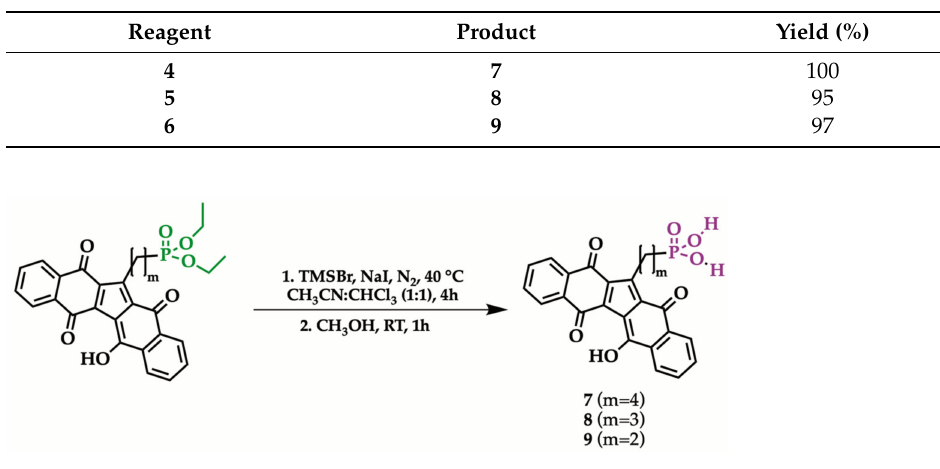
Table 3. Hydrolysis of KuQuinone phosphonate esters. Conditions: 0.1 mmol of diethyl phosphonate